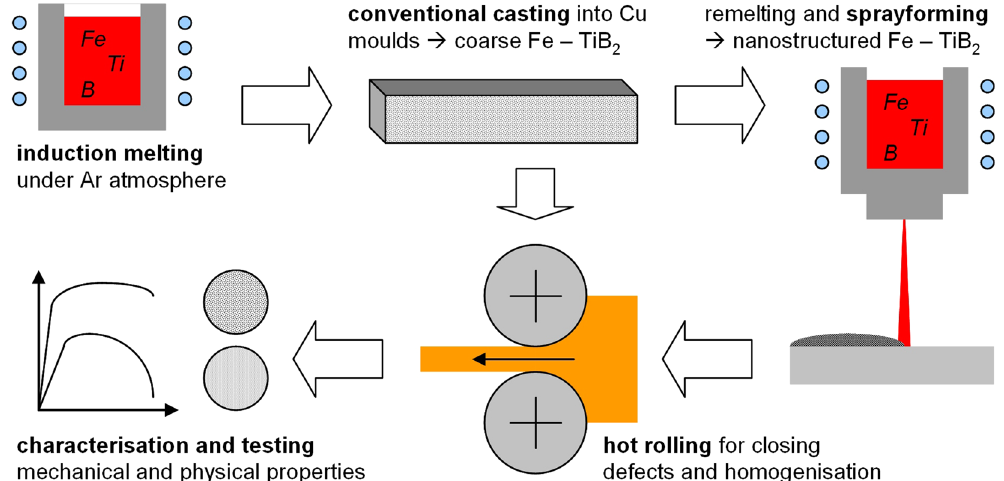
Figure 2. Sketch of the synthesis and processing routes used for the High Modulus Steels presented in this